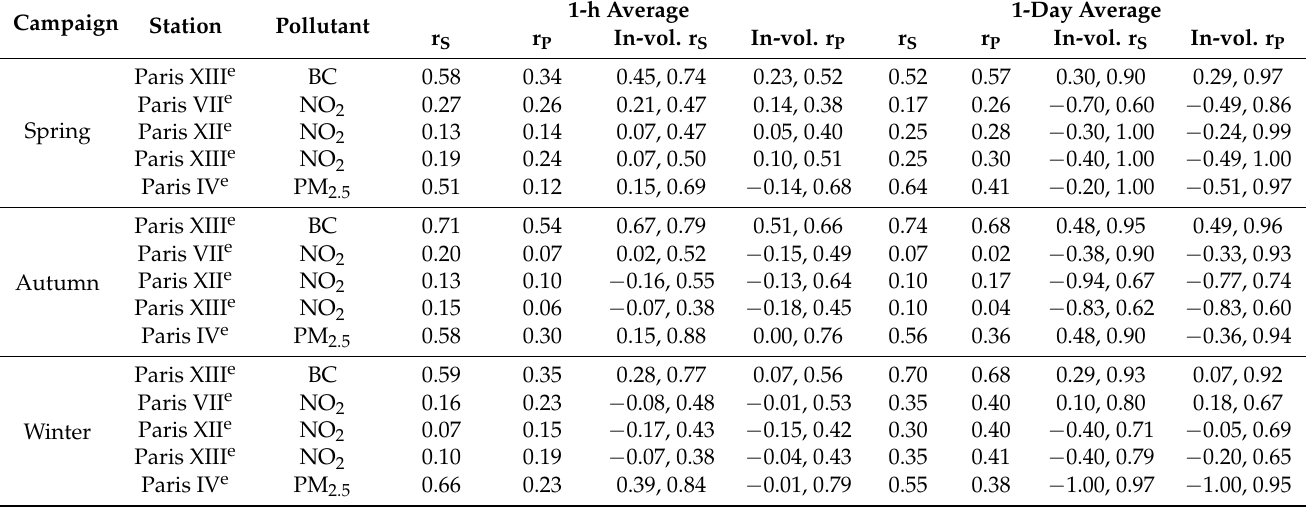
Table 4. Comprehensive correlations between PE to each pollutant (BC, NO 2 , and PM 2.5 )